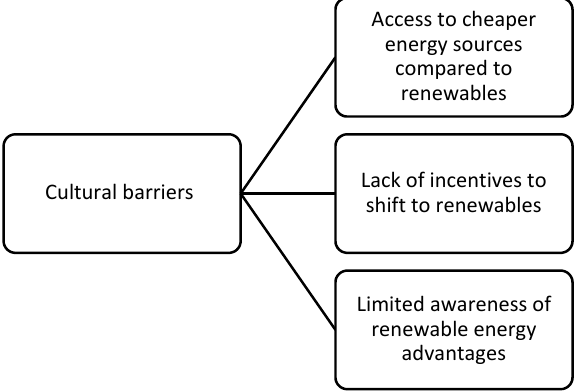
Figure 5. Cultural barriers for renewable energy adoption in the GCC. Adapted from [48].